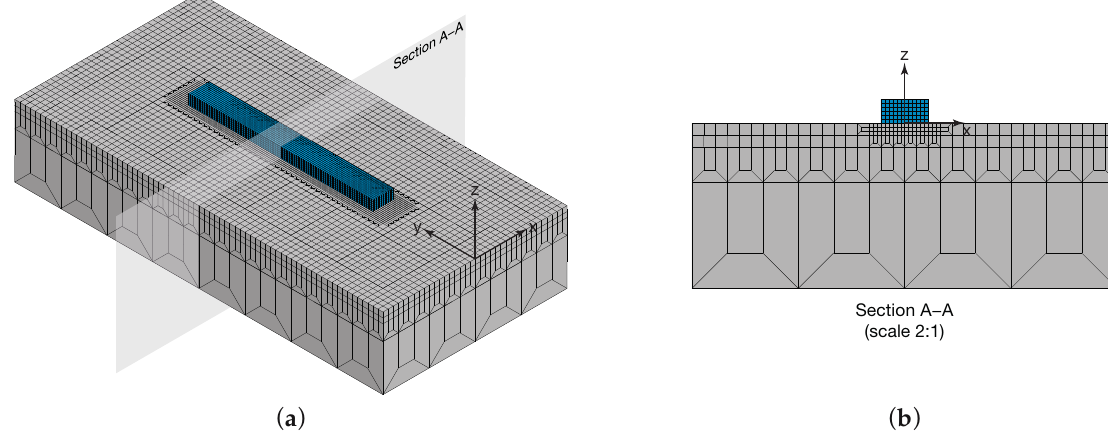
Figure 5. The geometry of the model consists of the substrate (grey) with overall dimensions of 10.8 × 21.6 × 4.2mm 3 and the activation volume (cyan) of 1.2 × 11 × 0.6mm 3 above the substrate. ( a ) Isometric view of the finite element model and ( b ) its cross-section on the XZ